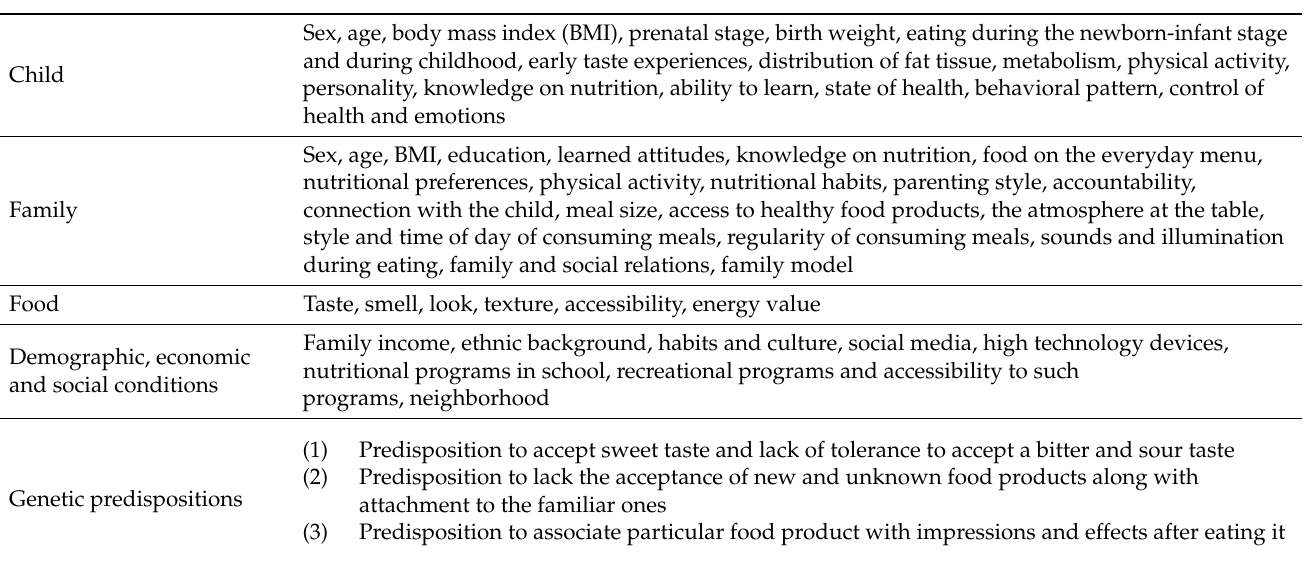
Table 1. The components affecting nutritional behavior, habits and